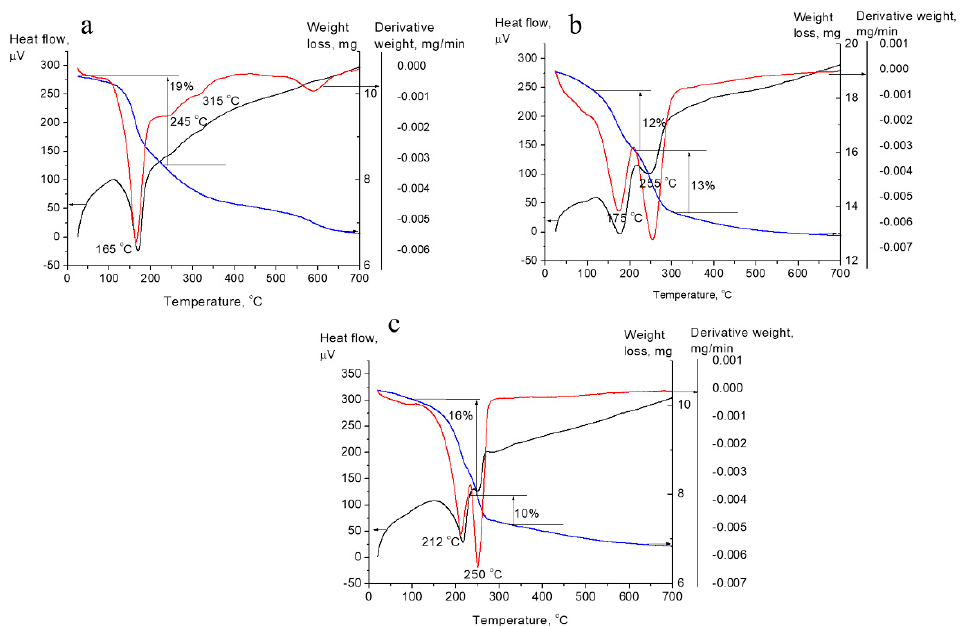
Figure 2. Curves of TG (blue line), DTG (red line), and DTA (black line) for the CuAl ( a ), CuCoAl ( b ),